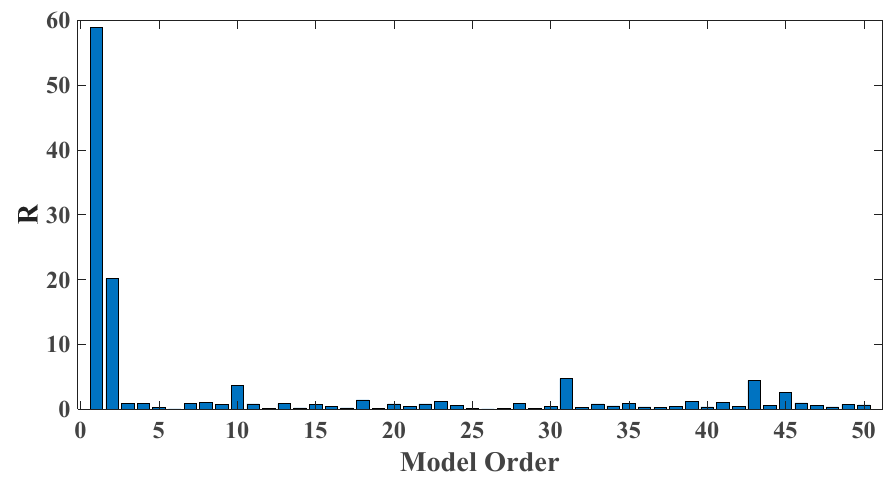
Figure 10. Evaluation index of damage detection results using various AR orders under the case of 30% damage occurring on the third floor (mutually correlated white noises inputs, 5% noise).